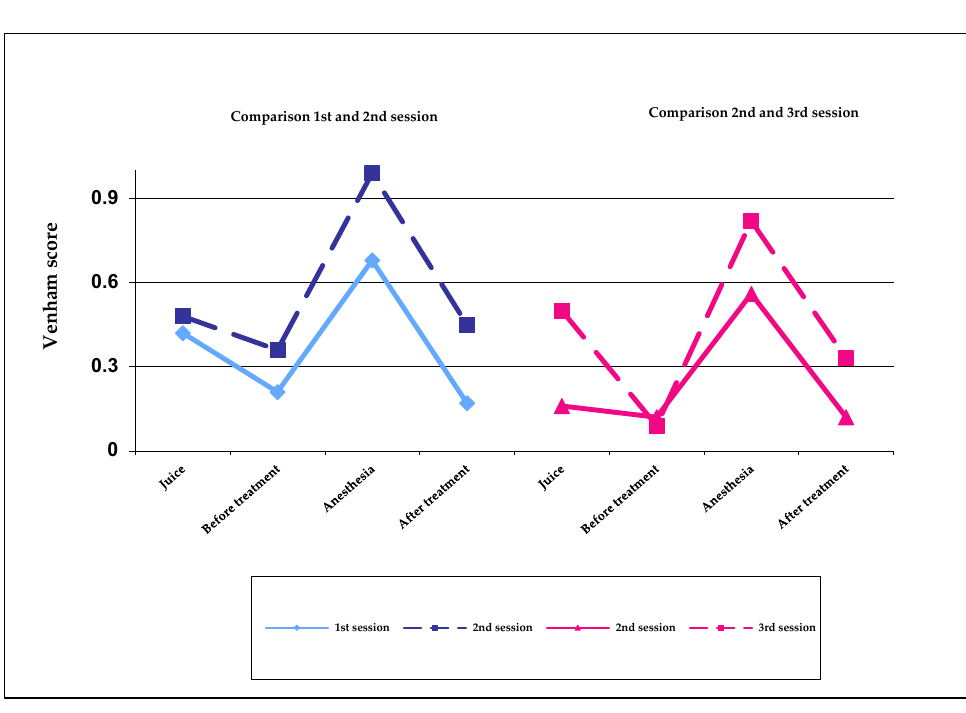
Figure 2. Venham score of the individual treatments . Only during polishing and when inserting the child’s crown are the values signifi- cantly lower than in the first and second session. The highest value of 1.52 is achieved in the third session when using the red handpiece. It is therefore even higher in the third session than the value for the extraction with 1.29. As these children were all anesthetized,